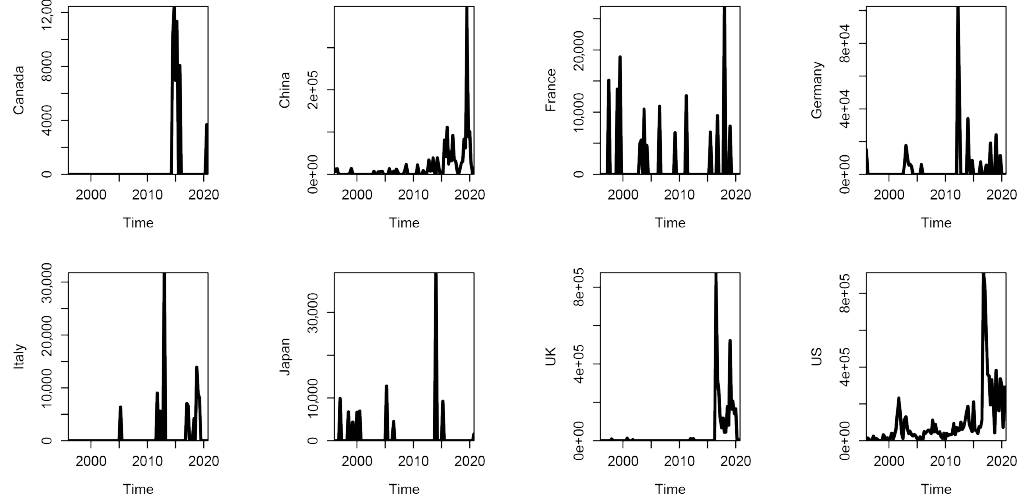
Figure 3. Time series of international spillovers. For better readability, the vertical axes of the panels are not the same for all time